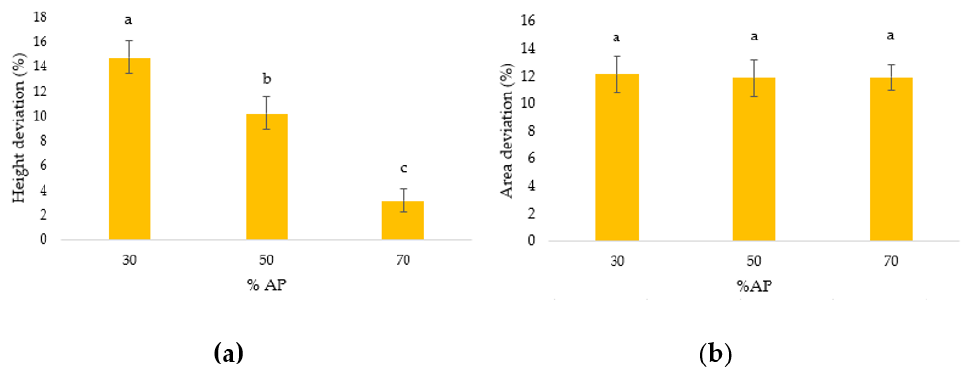
Figure 2. ( a ) Deviations of the height parameter of the samples; ( b ) Deviations of the area parameter of the sample (30: 30% of apricot pulp content; 50: 50% of apricot pulp content; 70: 70% of apricot pulp content). Letters (a – c) indicate homogeneous groups according to ANOVA ( p < 0.05).